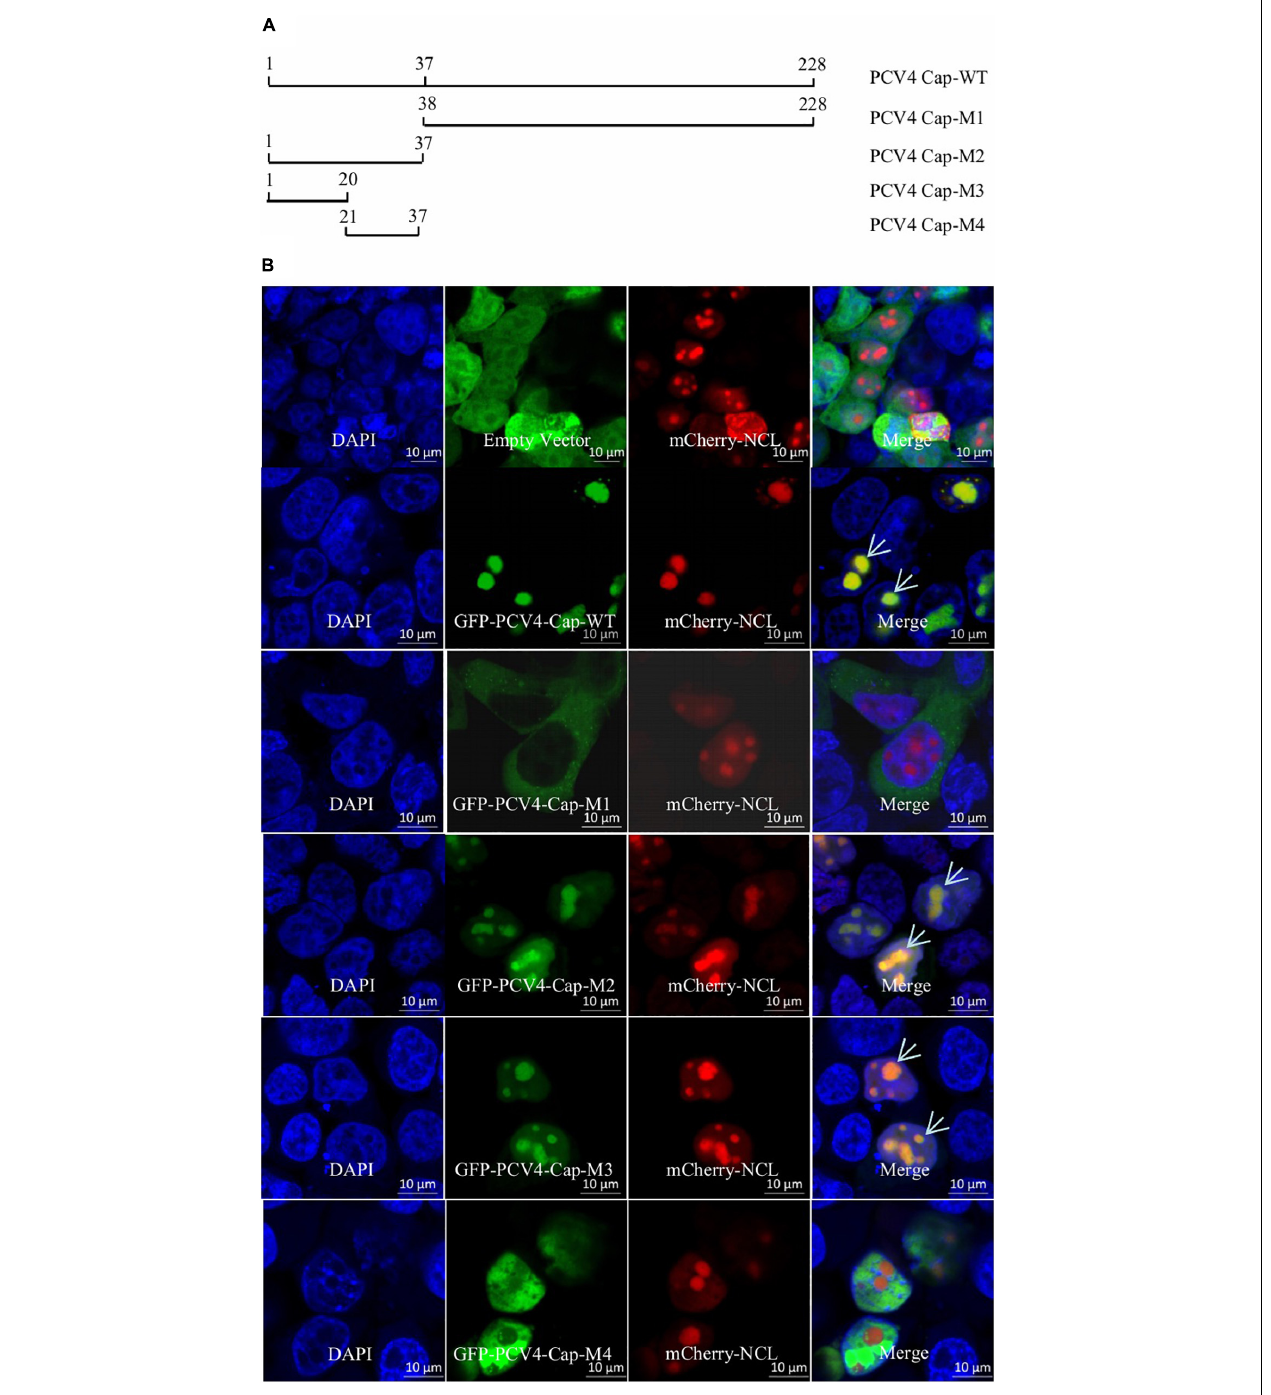
FIGURE 1 | The N-terminal residues 1–37 of PCV4 Cap are a nucleolar localization signal. (A) Schematic depicting the truncated mutants of PCV4 Cap in the context. (B) HEK293T cells were co-transfected with mCherry-NCL and GFP-PCV4-Cap-WT, Cap-M1, Cap-M2, Cap-M3, or Cap-M4 for 24 h. The HEK293T cells were incubated with DAPI and then observed under a confocal microscope. Scale bar, 10 µ